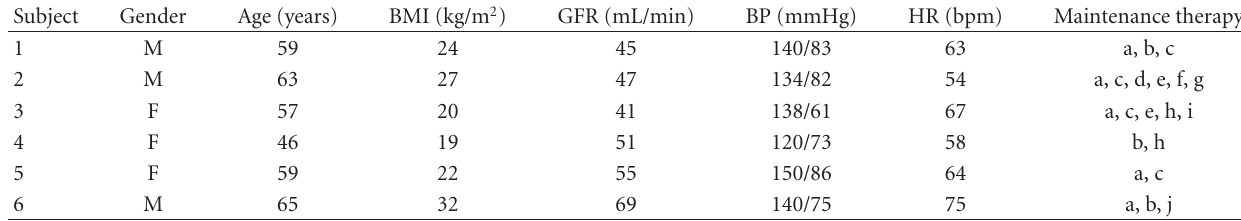
Table 1: Renal patients, baseline characteristics.